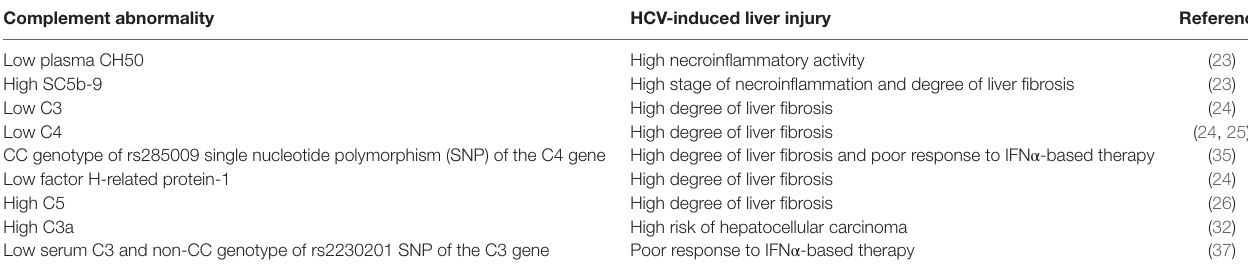
TABLe 1 | Complement system abnormalities in HCV-induced liver injury. Complement